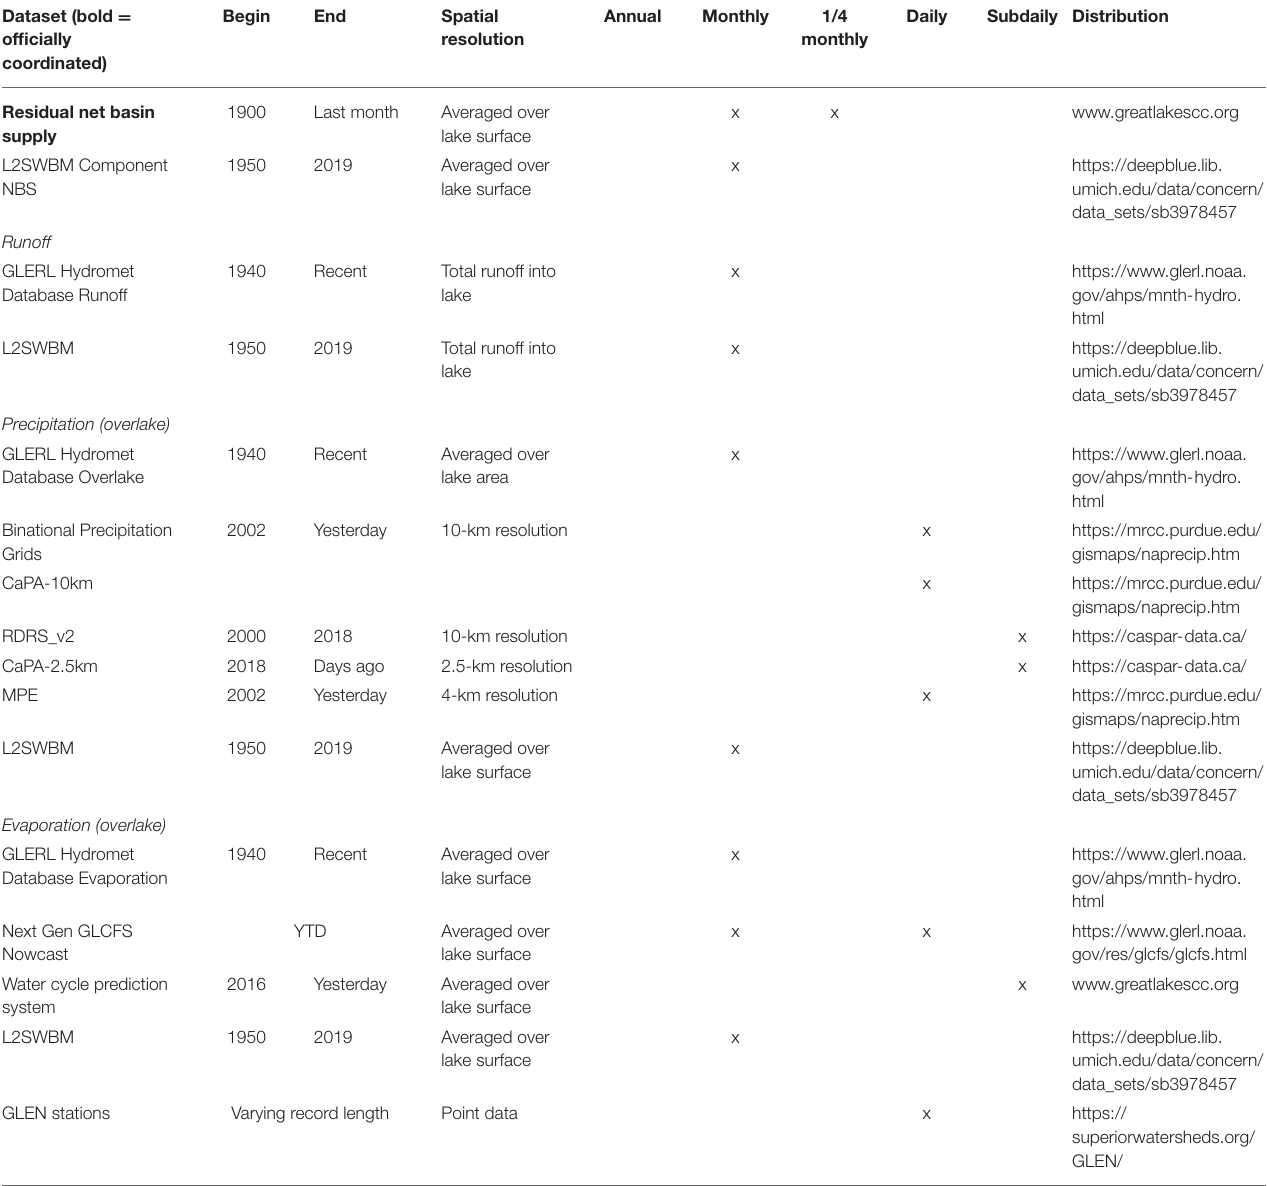
TABLE 3 | Net basin supply (NBS) and NBS component data products. Dataset (bold = officially